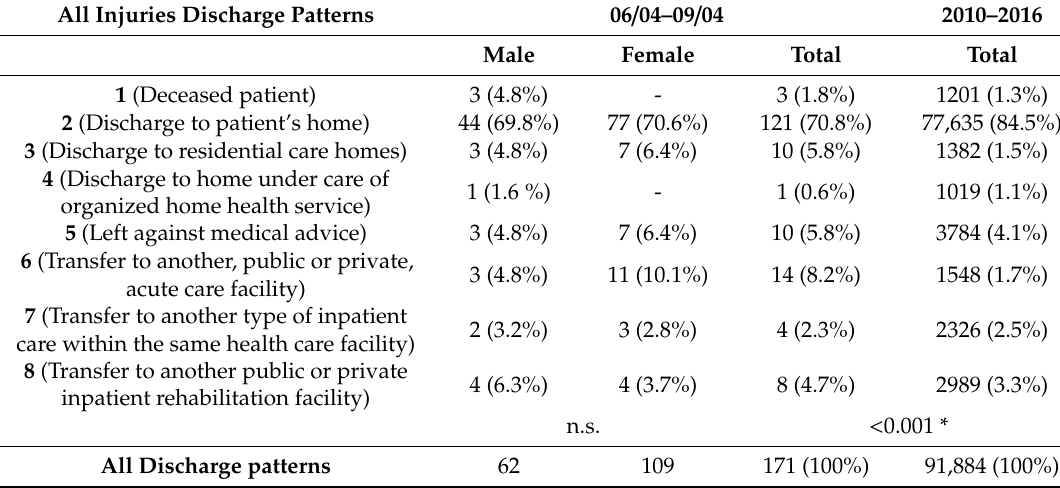
Table 8. Comparison of discharge patterns for patients admitted to hospital (total and divided by